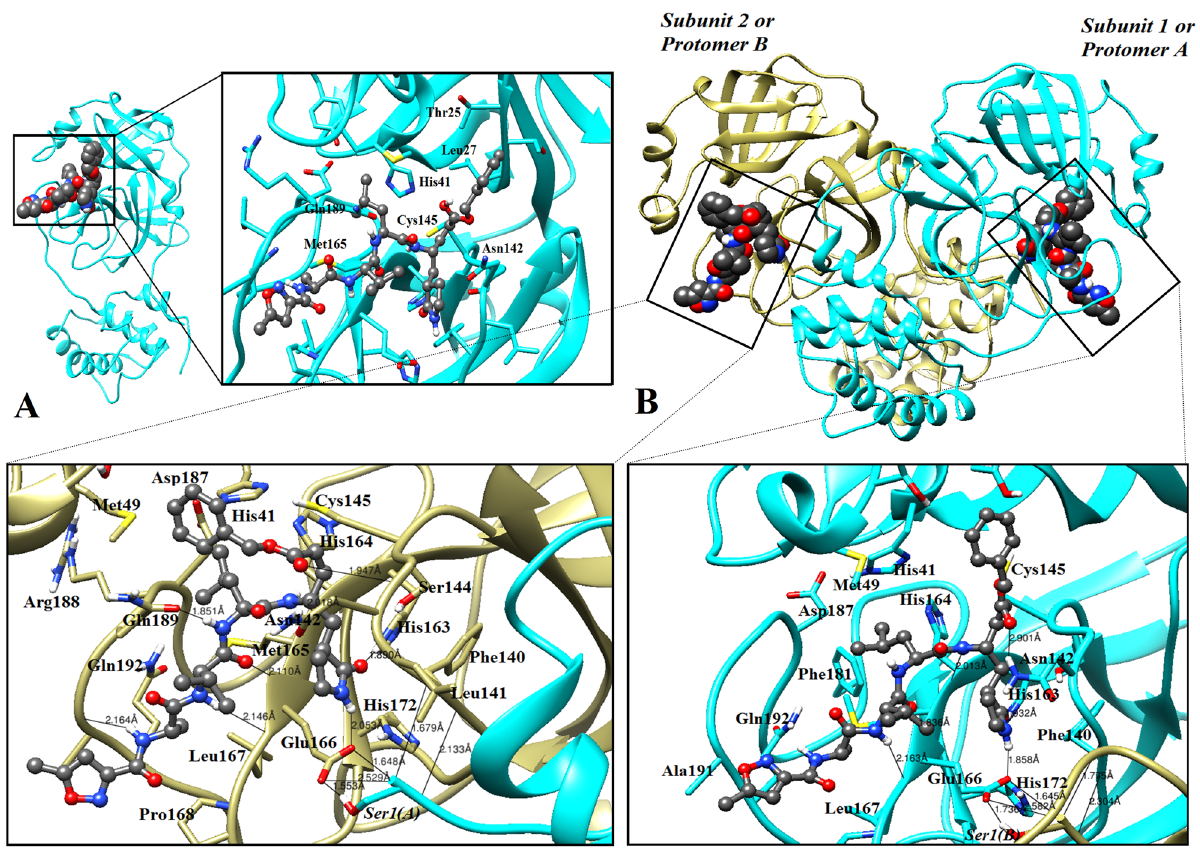
Figure 3. The binding modes of N3 inhibitor with protease active site. ( A ) The final step of MD simulation of Inhibitor N3 in protease active site in monomeric state (crystal structure conformer from 6LU7) after MD simulation. ( B ) The final step of MD simulation of N3 inhibitor with homo-dimeric. Identical residues interacted with inhibitor N3 depicted by stick form. Protease colored by cyan; ligands indicated by sphere, ball and stick form; inhibitor N3 is in grey dark.